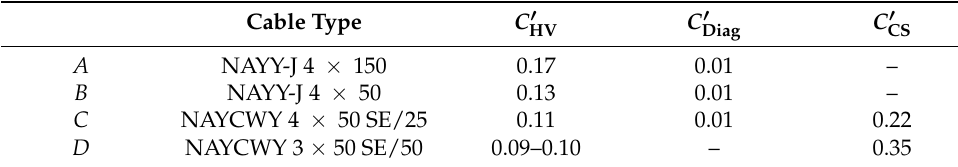
Table 7. Measured capacitances in µF